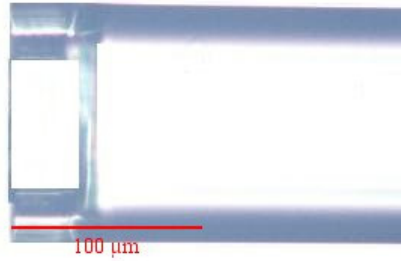
Figure 5. Structure diagram of sensor.